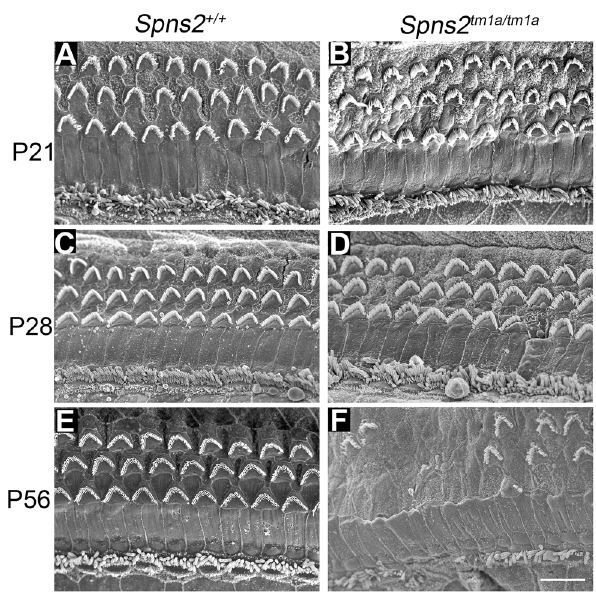
Figure 3. Progressive deterioration of hair cells shown by scanning electron microscopy. Spns2 tm1a/tm1a mice have a normal structure of hair bundles compared with wildtype mice at P21 ( A,B ). Scattered or patchy outer hair cell (OHC) degeneration was observed in the middle turn at P28 ( C,D ). Most stereocilia of OHCs in basal and middle turn have degenerated and stereocilia of IHCs were fused or lost at P56 ( E,F ). All the images were taken from the middle turn of the cochlea, defined as 40–70% of the distance along the cochlear duct from the base. Scale bar: 10 m m.